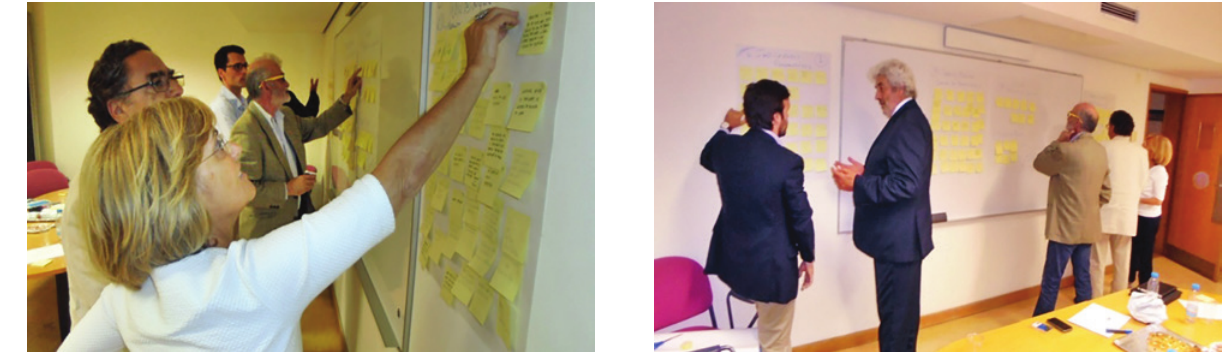
Figure 2. Snapshots of the application of the “post-its